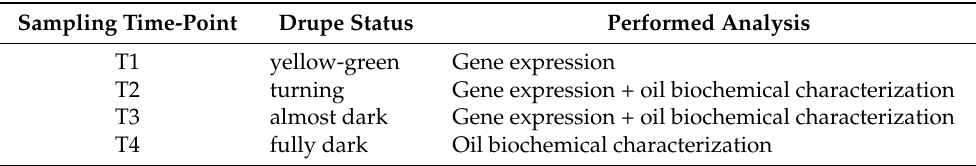
Table 1. Overview of the four drupe-collecting stages and type of analysis carried out in this study. Sampling